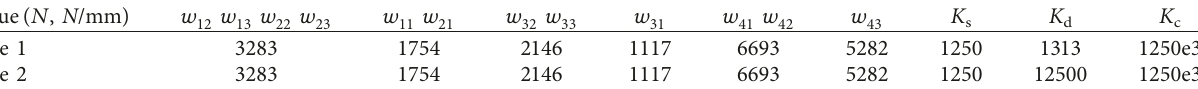
Shear spring for diaphragm, Kd Shear spring for shear wall,